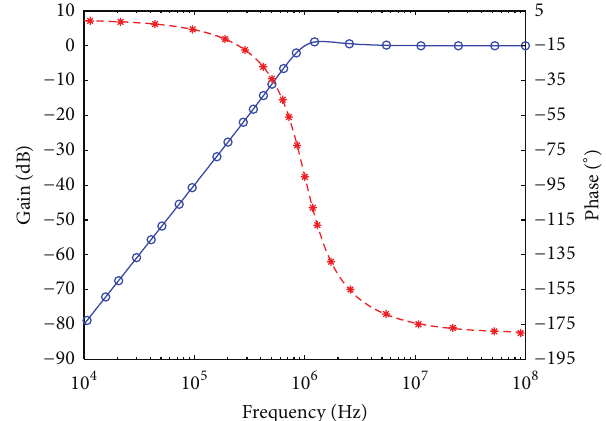
Figure 9: Simulated gain-frequency and phase-frequency responses of inverting high-pass filter at 𝑉 𝑜3 ( ∘ : simulated gain; ∗ : simulated phase; — and ---: theoretical